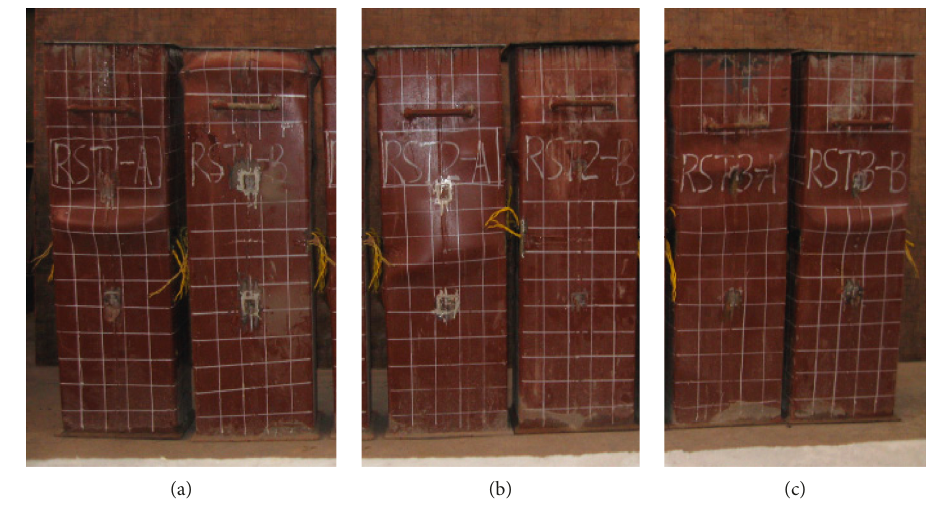
Figure 4: Failure modes. (a) RST1. (b) RST2. (c) RST3.